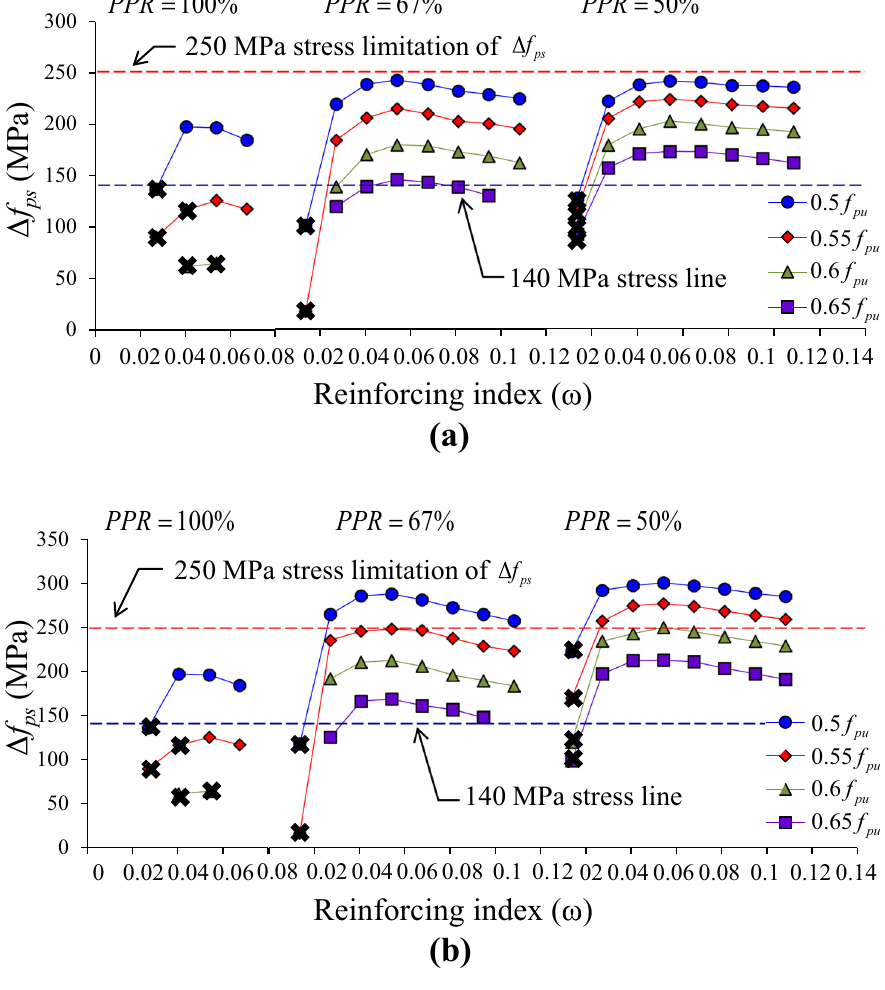
Fig. 10 Analysis results of Tee sections. a TS series with 420 MPa nonprestressed reinforcement and b TS series with 550 MPa nonprestressed